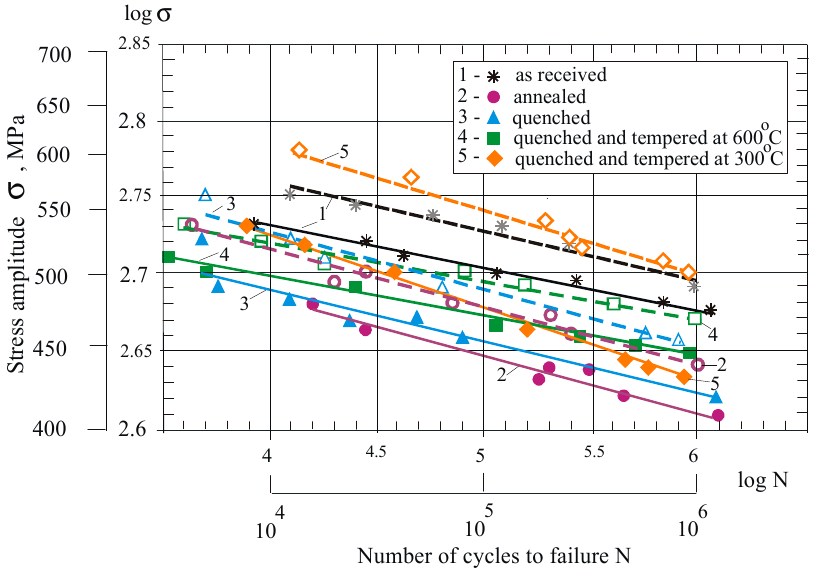
Figure 12. Effect of heat treatment and severe surface plastic deformation on fatigue behaviour of Cu-10Al-5Fe bronze: dashed lines correspond to severe surface plastic deformation via DB.